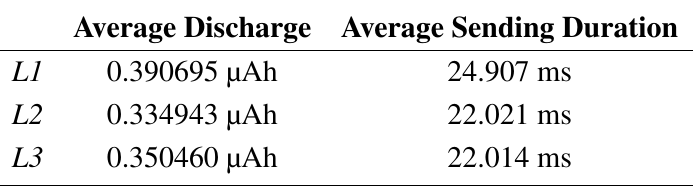
Table 3. Energy statistics L1–L3 for measurement 3.